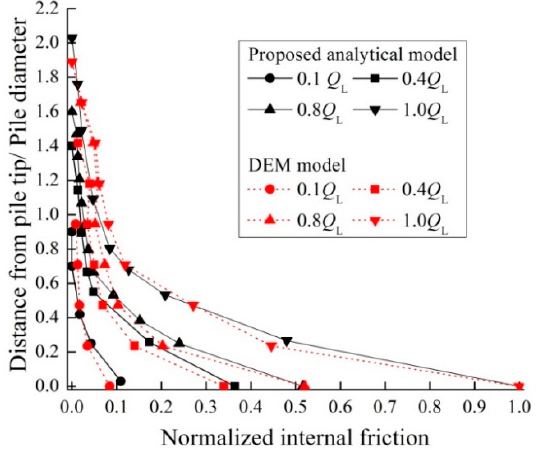
Figure 15. The internal friction from the analytical method and DEM model.